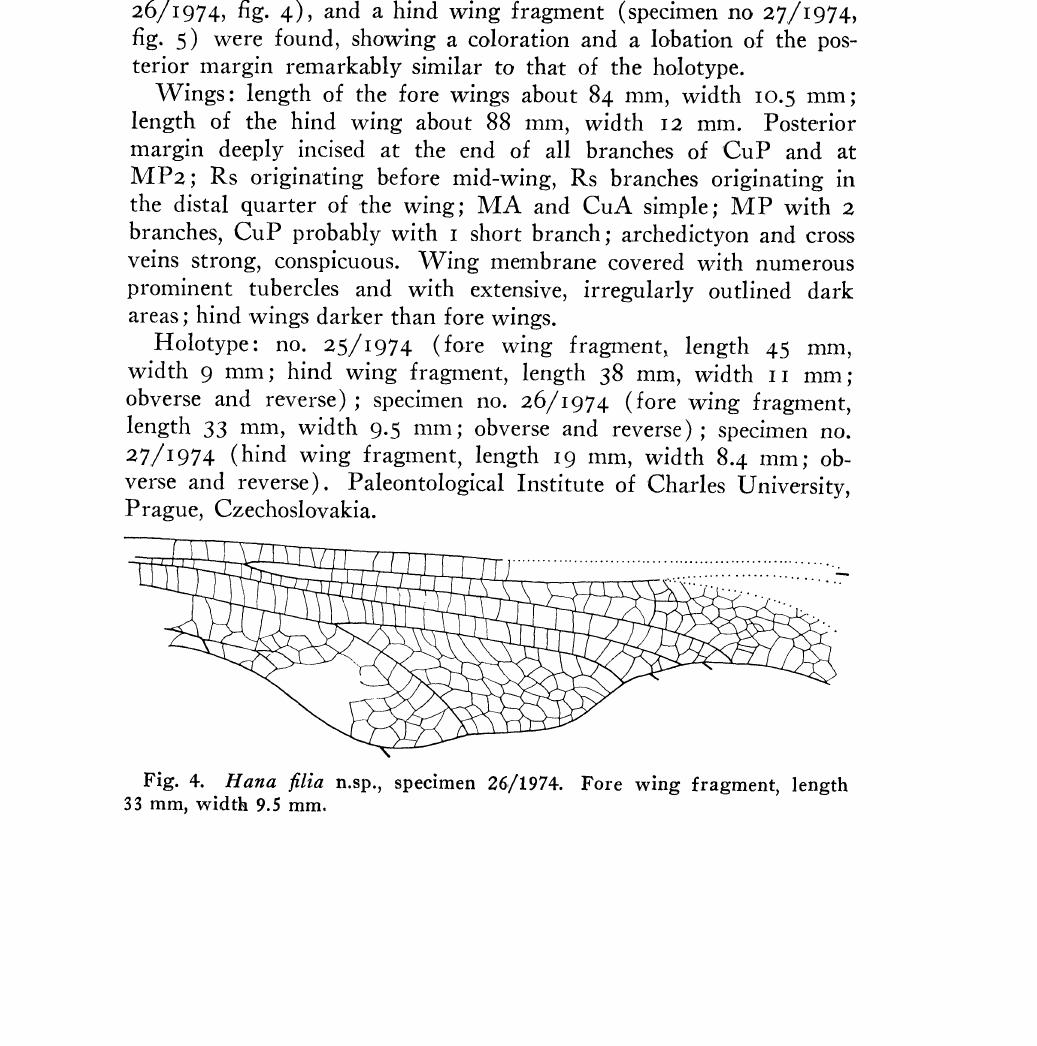
Fig. 4. Hana filia n.sp., specimen 26./1974. Fore wing fragment, length 33 mm, width 9.5